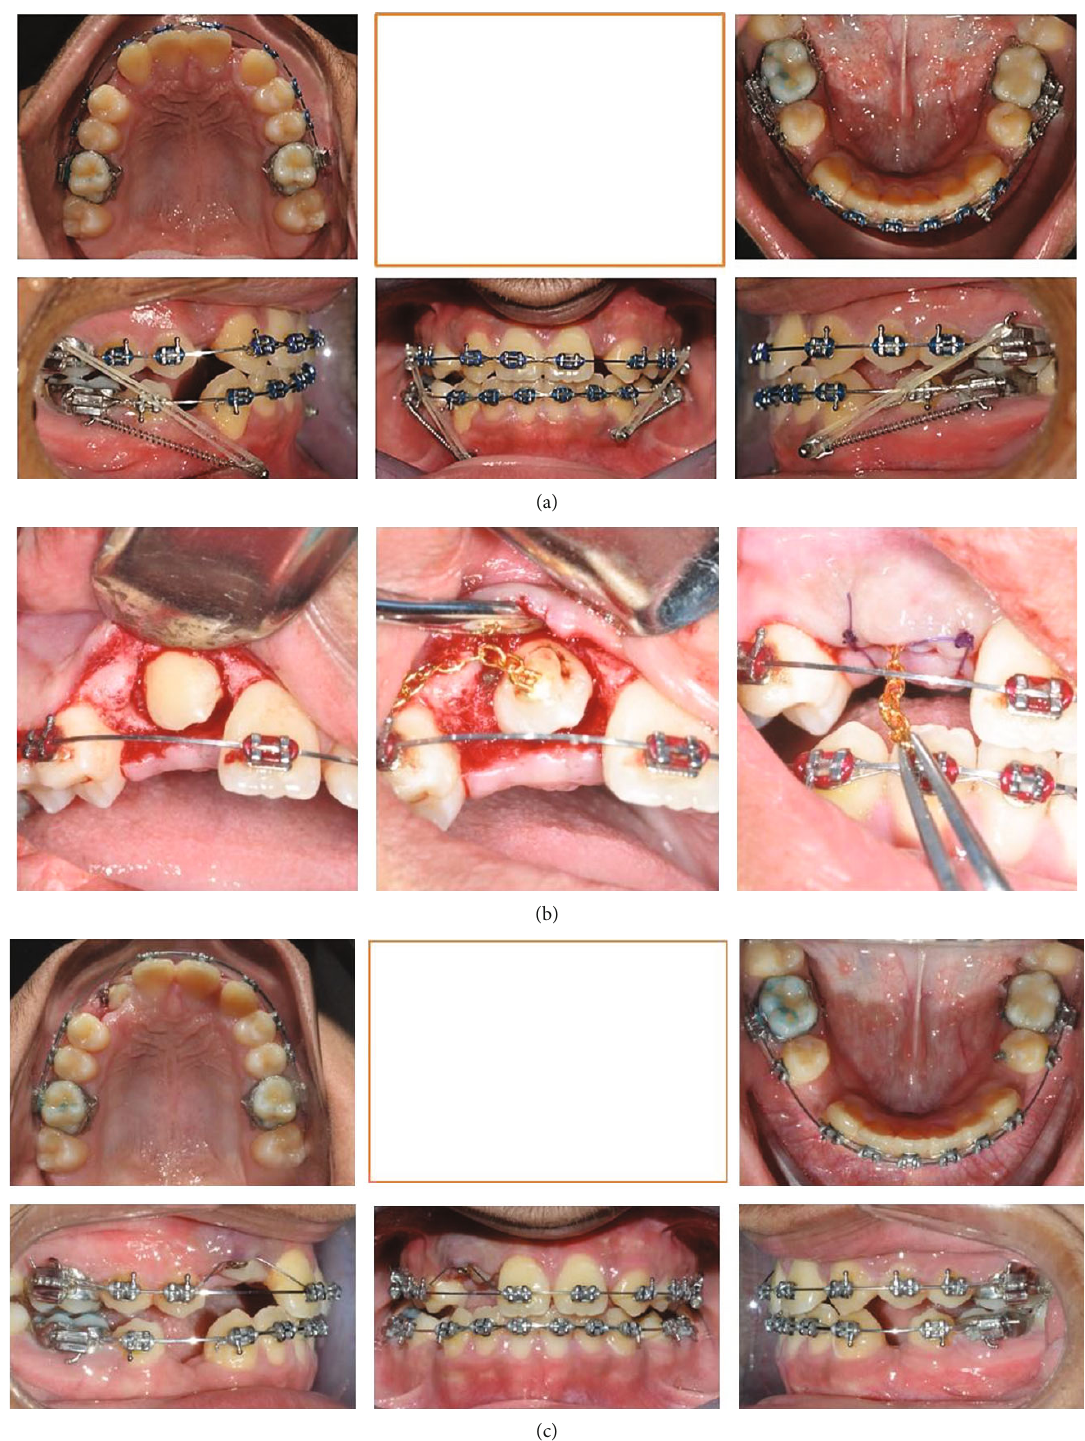
Figure 3: Multiple progress photographs (a –